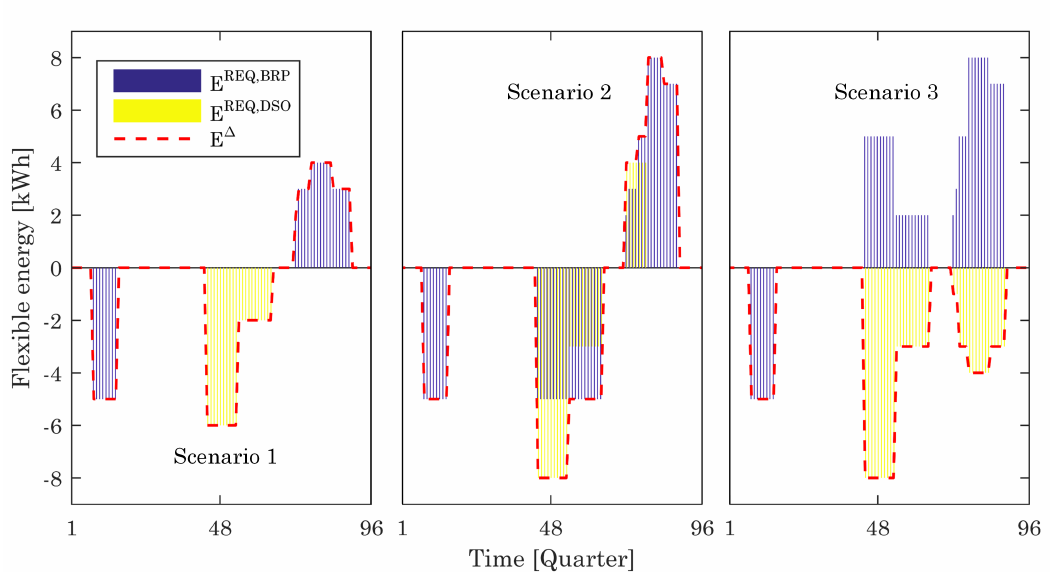
Figure 8. The DSO and BRP flexibility requests in the three